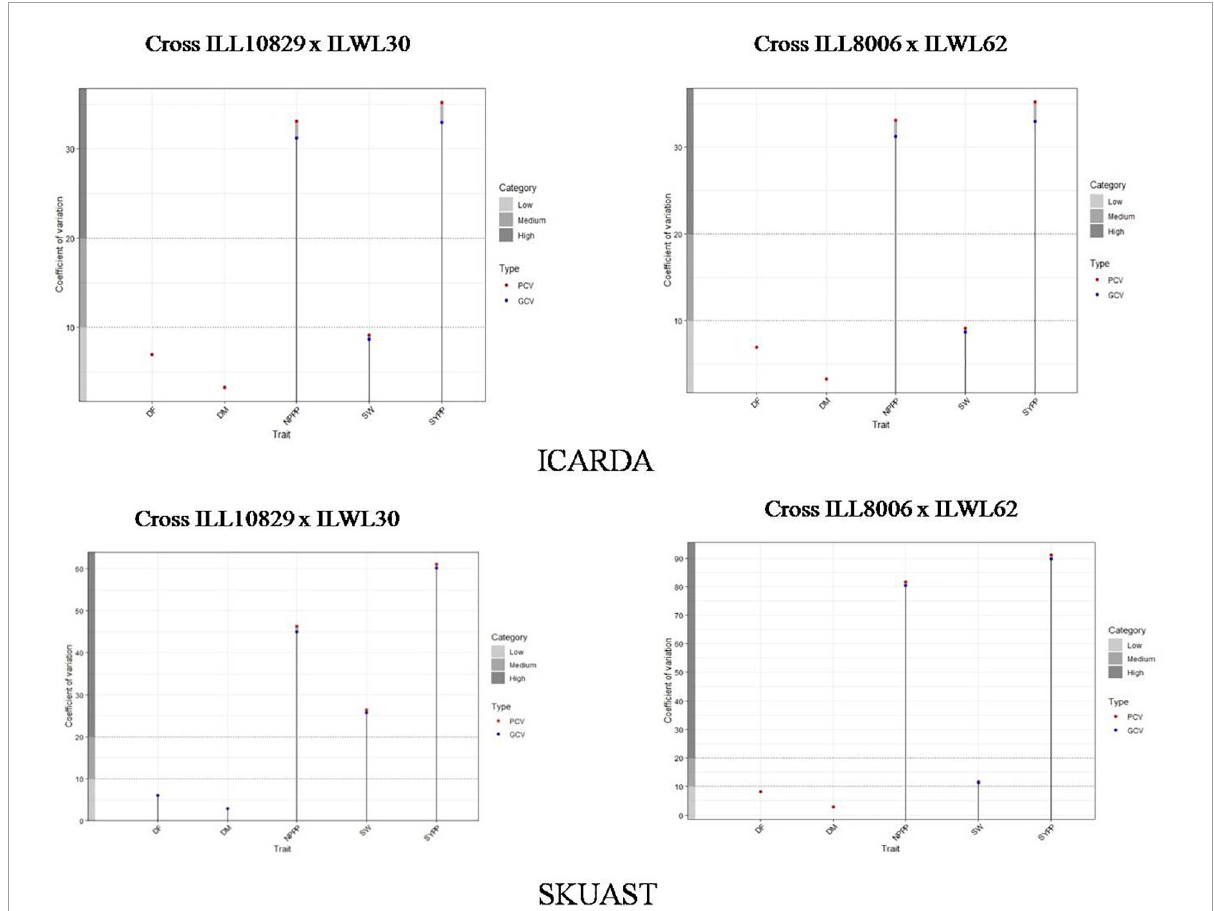
FIGURE2 Estimation of the coefficient of variation for lentil interspecific derivatives at ICARDA and SKUAST, India. DF, days to 50% flowering; DM, days to 80% maturity; NPPP, number of pods plant - 1 ; SW, 100-seed weight; SYPP, seed yield plant - 1